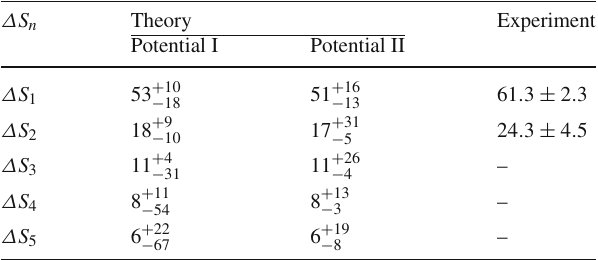
Table 8 Differences Δ S n = n 3 S − n 1 S . We observe that these dif- ferences decrease when n is increased. All the differences reported in this Table are in MeV. These values have been obtained by mean of bootstrap technique. The experimental errors, in the fourth column, has been summed in